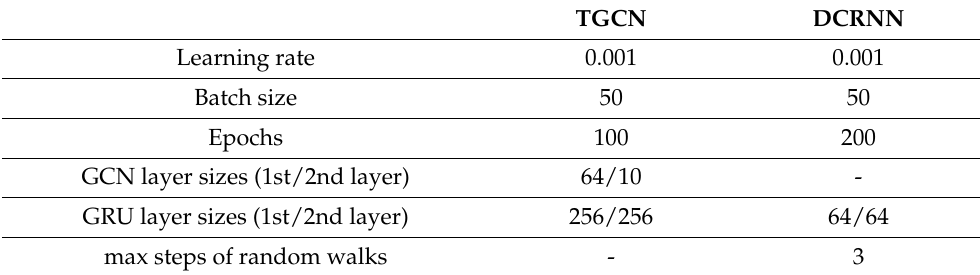
Table 1. Optimal hyper-parameter values for the two forecasting models.